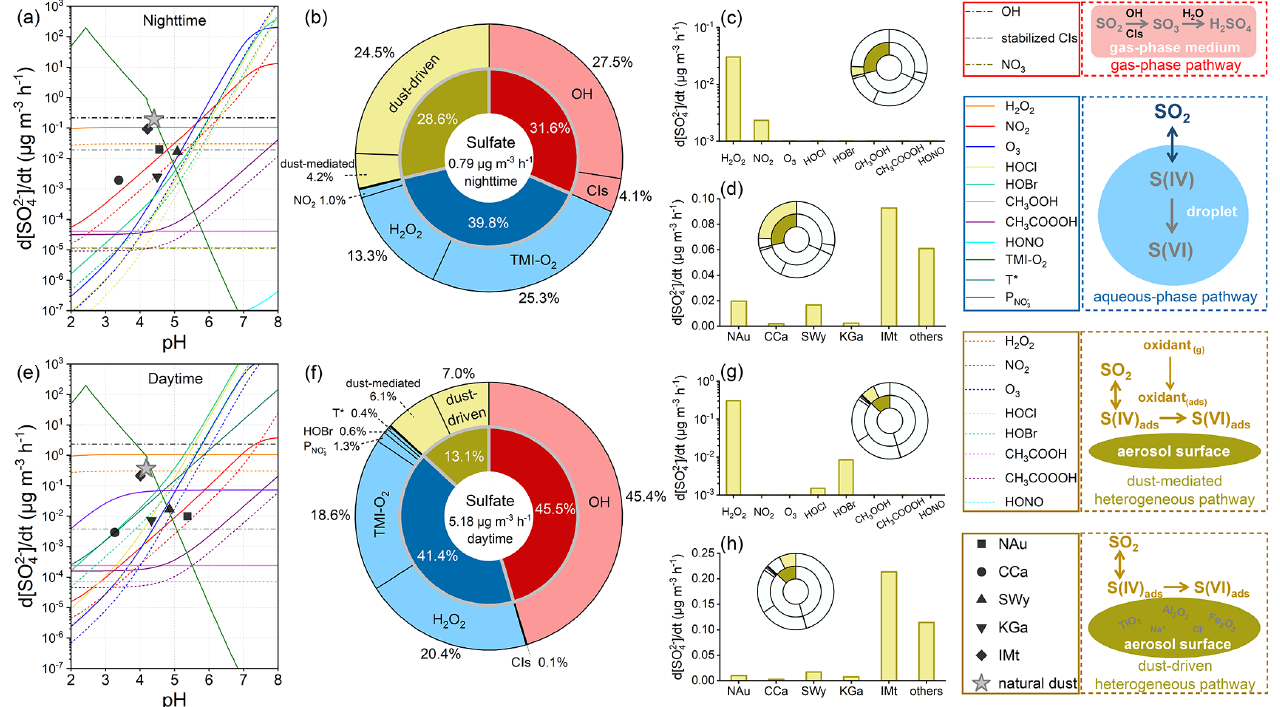
Figure 6. Contributions of diverse atmospheric oxidation pathways to secondary sulfate aerosols. Gas-phase oxidation can be induced by the hydroxyl radical (OH), stabilized Criegee intermediates (CIs), as well as nitrate radical (NO 3 ) only for nighttime. Aqueous-phase oxidation can be induced by hydrogen peroxide (H 2 O 2 ), NO 2 , O 3 , HOCl, HOBr, CH 3 OOH, CH 3 COOOH, HONO, TMI-O 2 , and the T ∗ and P only for daytime. Dust-mediated heterogeneous oxidation can be initiated by the surface oxidants (H 2 O 2 , NO 2 , O 3 , HOCl, NO − 3 HOBr, CH 3 OOH, CH 3 COOOH, HONO) co-adsorbed with SO 2 . Dust-driven heterogeneous oxidation can be ascribed to the heterogeneous drivers (transition-metal-bearing components and water-soluble ions) on the surfaces of natural dust and clay minerals – nontronite (NAu), chlorite (CCa), montmorillonite (SWy), kaolin (KGa), and illite (IMt). The (a–d) nighttime and (e–h) daytime conditions were distinguished by the different parameterizations. (a, e) Particle acidity-dependent sulfate formation rates of the diverse atmospheric oxidation pathways. The elements’ colours and shapes are characterized by the legends in solid boxes. (b, f) Quantified sulfate contribution proportions of the studied gas-phase (red), aqueous-phase (blue), and heterogeneous (yellow) reaction pathways. Sulfate formation rates of the dust-mediated and dust-driven pathways during (c–d) nighttime and (g–h) daytime. The effects of ionic strength on the aqueous-phase oxidation were not taken into account. The dust concentration was set to 55µgm − 3 , representative of the common atmospheric condition of North China (X. Y. Zhang et al., 2012). The panels in dashed boxes right of the legends illustrate the primary physical–chemical processes of atmospheric sulfate formation. More parameterization and methodology details can be found in Texts S2–S4 of the Supplement and Sect. 2.1–2.5 of the main